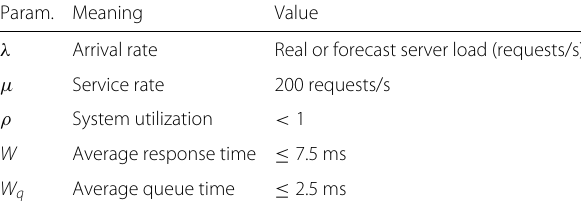
Table 3 M/M/c queueing model parameters Param.